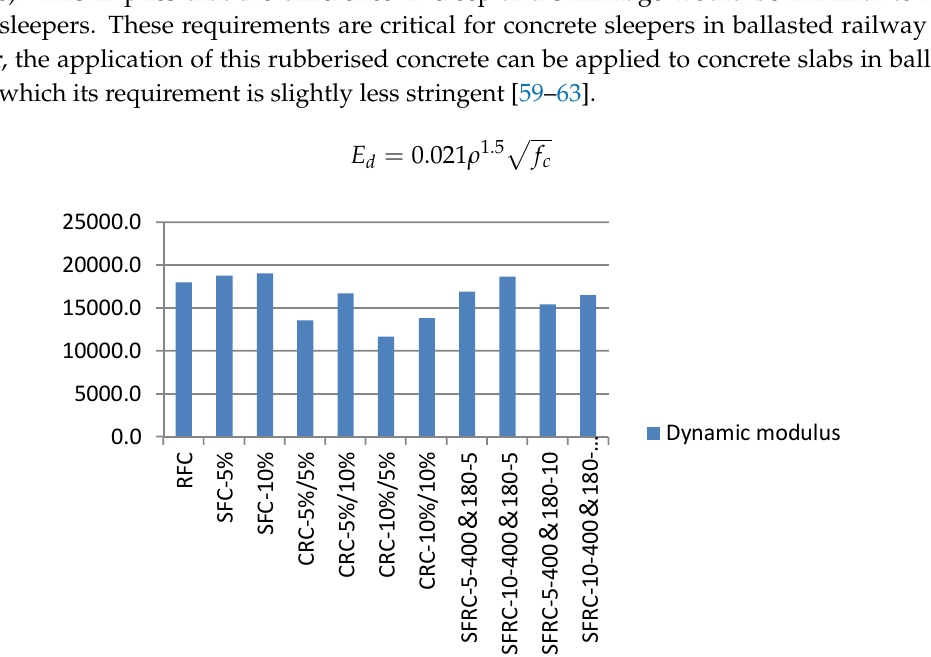
Figure 21. Early-age dynamic moduli of crumb rubber concrete at 7 days (MPa).